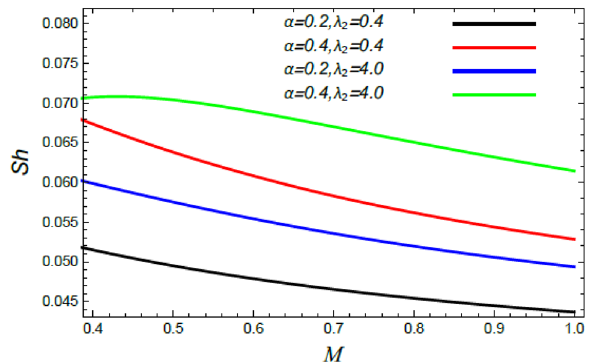
Figure 33. Sherwood number versus M as given in Eq. (38) to illustrate the impact of the stretching factor α and Deborah parameter (cid:31) 2